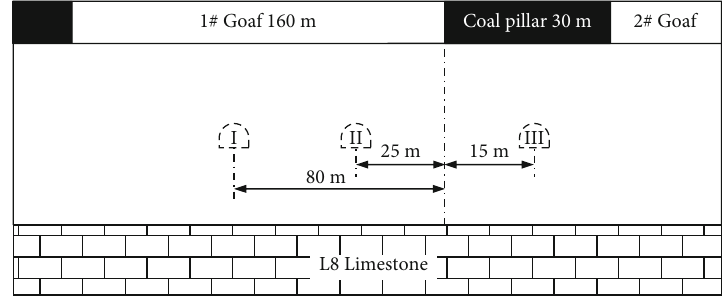
Figure 2: Simulation layout scheme of fl oor